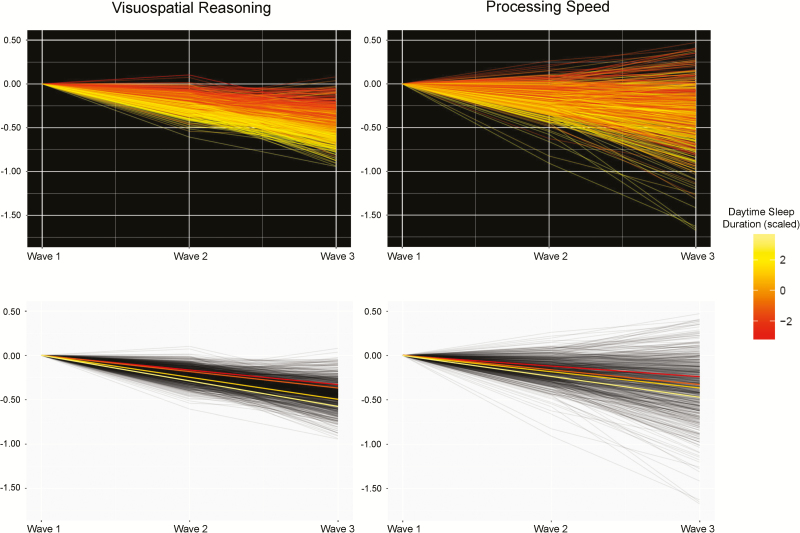
Significant associations between greater daytime sleep duration at age 76 and 6-year cognitive decline. Cognitive factor scores at each wave were extracted from the structural equation models in which both outcome and predictor variables are corrected for sex, intra-wave age variation, and time-varying health measures (HADS, BMI, hypertension, diabetes, cardiovascular history, and arthritis), and were normalized for wave 1 score to illustrate individual differences in trajectories of change. Top row: individual cognitive trajectories as modeled (continuous), and are shaded to indicate less-more (red-yellow) daytime sleep duration. Bottom row: regression lines for four equally sized groups of daytime sleep duration in the same data, for illustration purposes only.